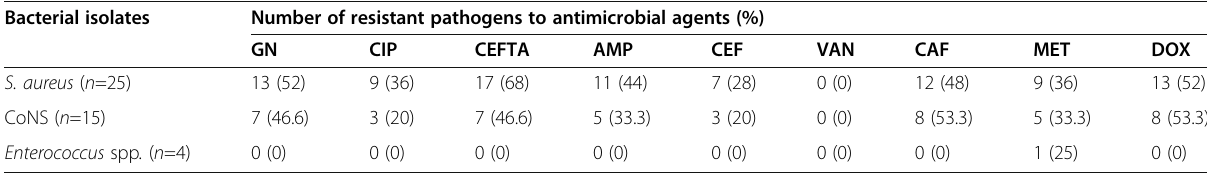
Table 6 Antimicrobial susceptibility patterns of gram-positive bacterial isolates from wound swab cultures of postoperative surgical site infections Bacterial